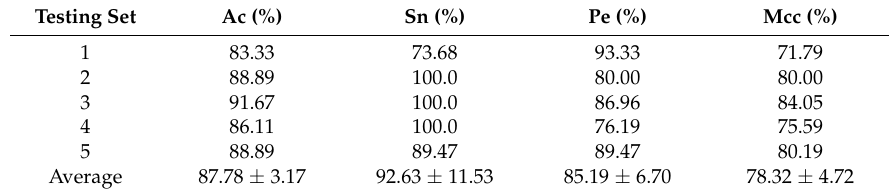
Table 4. 5-fold cross validation results performed by proposed model on a nuclear receptor dataset.